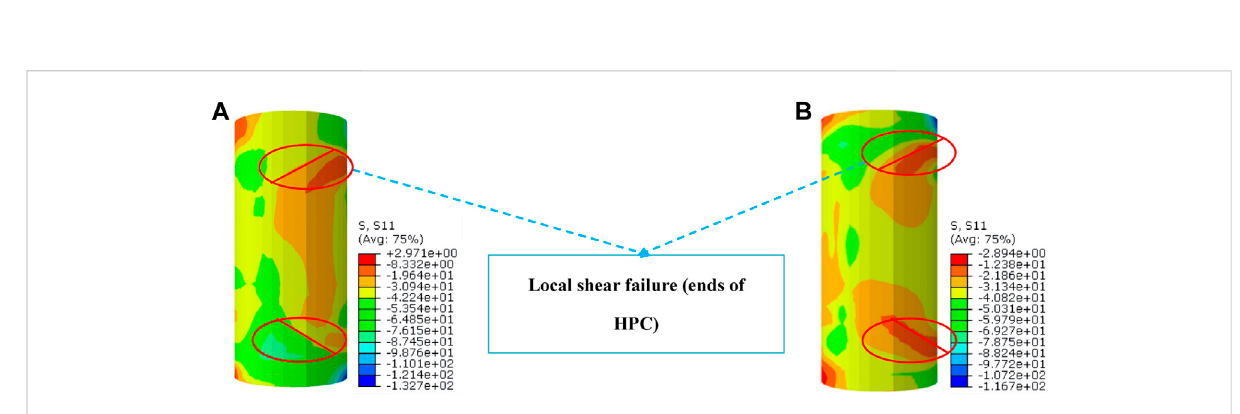
FIGURE 14 Local shear of concrete at the end of two typical specimens. (A) HCHST-19; (B)